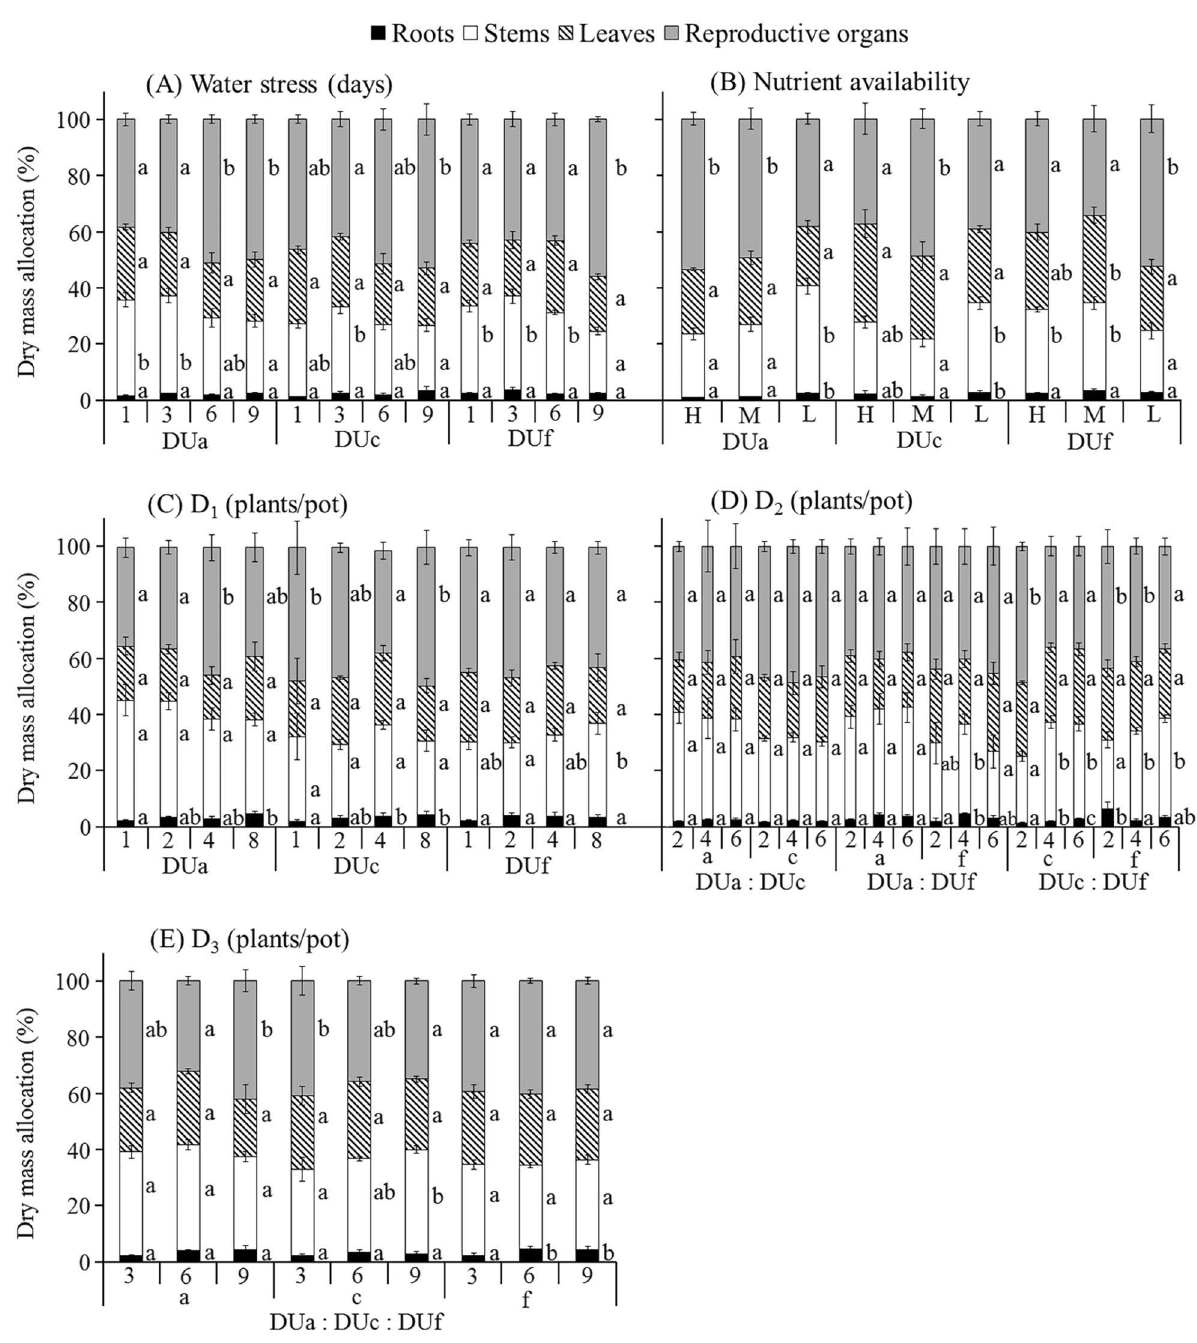
Figure 4. Effect of water stress ( A ), nutrient availability ( B ) and pure ( C ) and mixed ( D , E ) density on dry mass allocation to roots, stems, leaves and reproductive organs of Ceratocarpus arenarius plants derived from each dispersal unit morph (mean ± 1 SE). Only dry mass allocations ≥ 0.91% and standard errors ≥ 0.66% are shown. Different lowercase letters indicate significant differences in multiple range comparison among levels for all treatments of plants from the same dispersal unit morph ( P < 0.05). DUa, dispersal unit morph a; DUc, dispersal unit morph c; DUf, dispersal unit morph f; H, high; M, moderate; L, the ratio is < 1.00, production of (HDi-LDo) diaspore morphs is lower than that of (LDi-HDo) diaspore morphs. Thus, a decrease in the (HDi-LDo)/(LDi-HDo) morph ratio has been demonstrated for increasing soil water 18,21 , nutrient 15,36,37 , density 16,19 and herbivory 18 stress. Likewise, in the polymorphic diaspore species C. arenarius soil water, nutrient and density stress caused a decrease in proportion of dispersal unit morph f (HDi-LDo) with increase in intensity of all the three stresses, whereas proportion of dispersal unit morph a (LDi-HDo) increased with increase in intensity of all the three stresses. Moreover, proportion of dispersal unit morph c was the same as that of dispersal unit morph f (i.e. decreased) or a (i.e. increased) with increase in intensity of stress. Overall,